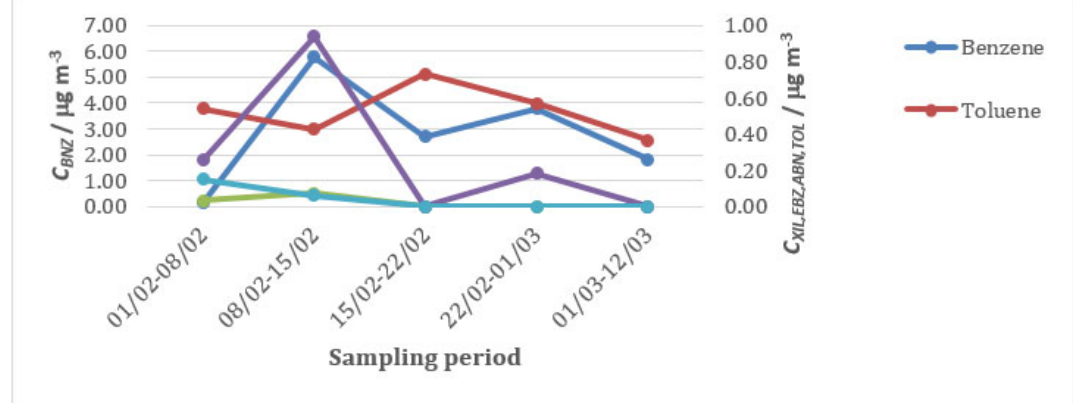
Figure 4. Mean VOC concentration for each sampling period on site O4E (balcony of classroom 4E).